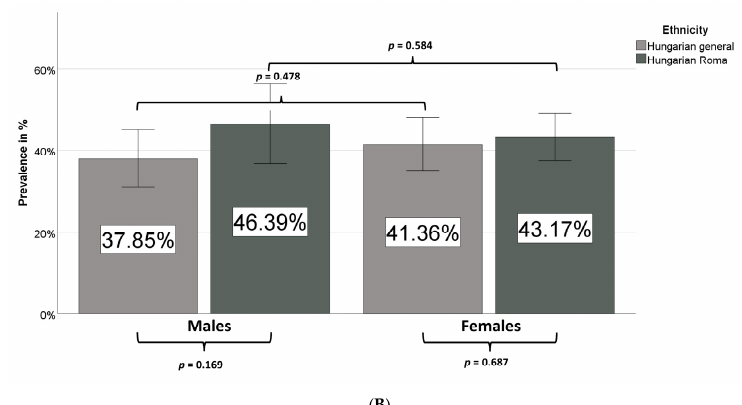
Figure 3. Prevalence of metabolic syndrome in different age groups ( A ) and sexes ( B ) in the Hungarian general and Hungarian Roma populations.